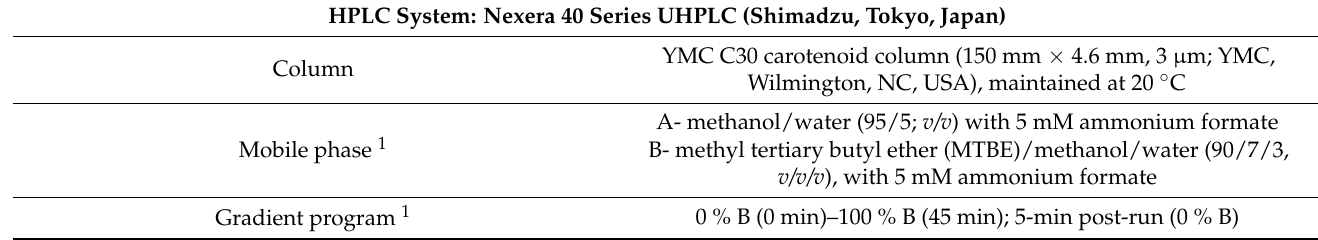
Table 1. LC-SIM-MS parameters used for the analysis of carotenoids and